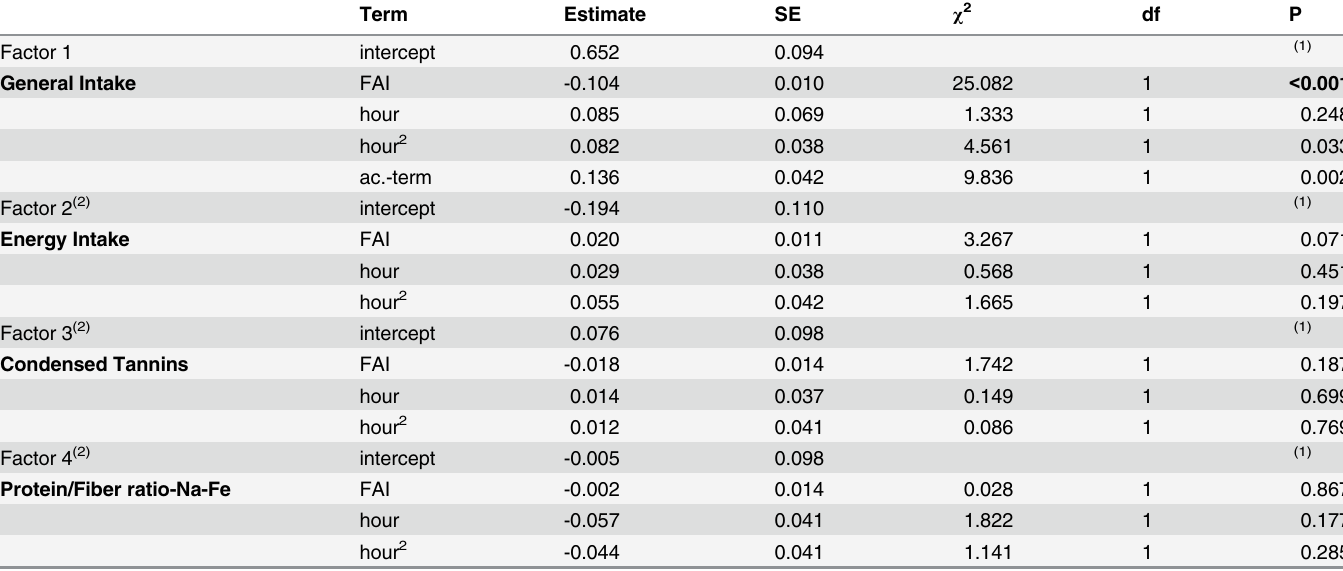
Table 4. Results of GLMMs with factor scores characterizing intakes as the response (sample size was N = 708 data points from six subjects in all